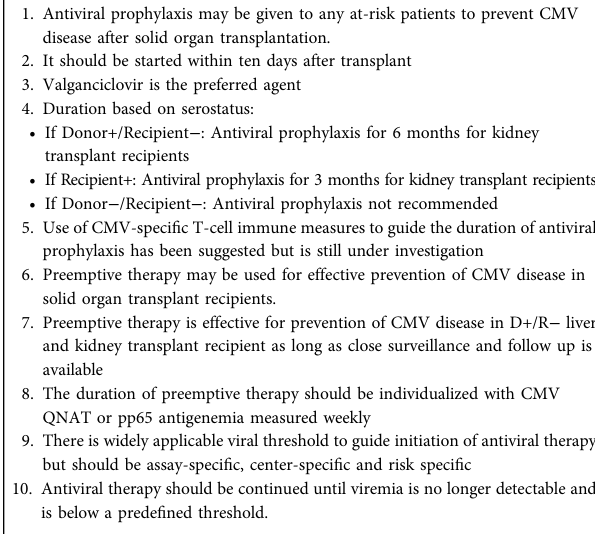
TABLE 1 Guidelines/recommendations per the American society of transplantation of infectious disease in regards to prevention are (3). 1. Antiviral prophylaxis may be given to any at-risk patients to prevent CMV disease after solid organ transplantation. 2. It should be started within ten days after transplant 3. Valganciclovir is the preferred agent 4. Duration based on serostatus: (cid:129) If Donor+/Recipient − : Antiviral prophylaxis for 6 months for kidney transplant recipients (cid:129) If Recipient+: Antiviral prophylaxis for 3 months for kidney transplant recipients (cid:129) If Donor − /Recipient − : Antiviral prophylaxis not recommended 5. Use of CMV-speci fi c T-cell immune measures to guide the duration of